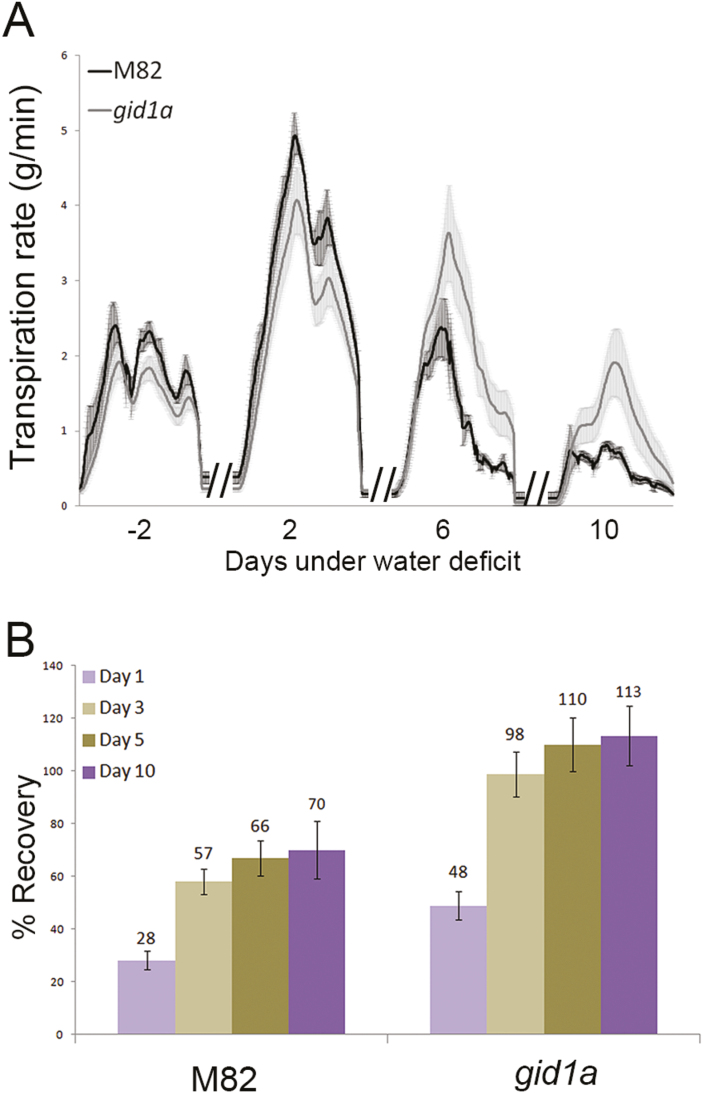
Loss of GID1a reduces transpiration under water deficit conditions. (A) Transpiration rate in M82 and gid1a under water limited conditions. After 2 weeks of irrigation on the lysimeters, irrigation was gradually reduced (50% of the previous day’s transpiration, automatically controlled by the system for each plant separately) until it was completely stopped. Transpiration rate in selected representative days during the water deficit treatment are presented; 2 d before the beginning of the water-deficit treatment (−2) and 2, 6, and 10 d into the drought treatment. Values are means of eight plants ±SE. (B) Recovery of M82 and gid1a from the drought treatment. Recovery was evaluated by the time required for each plant to return to the level of transpiration measured just before the beginning of the water-deficit treatment. Values are means of eight plants ±SE. Numbers above columns represent the percentage of maximum transpiration (see above).